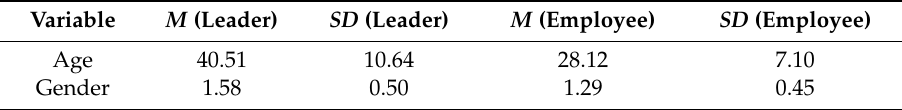
Table 1. Means and standard deviations for both leaders and